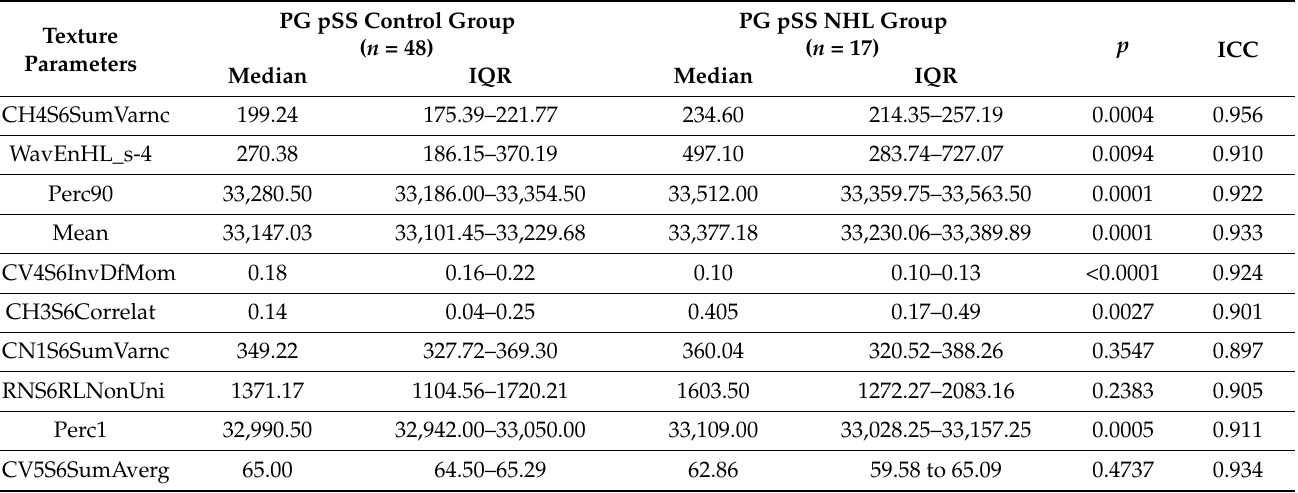
Table 3. Texture features associated with lymphoma development in patients with pSS after the POE + ACC (probability of classification error and average correlation coefficients) reduction tech- nique and the univariate analysis results.